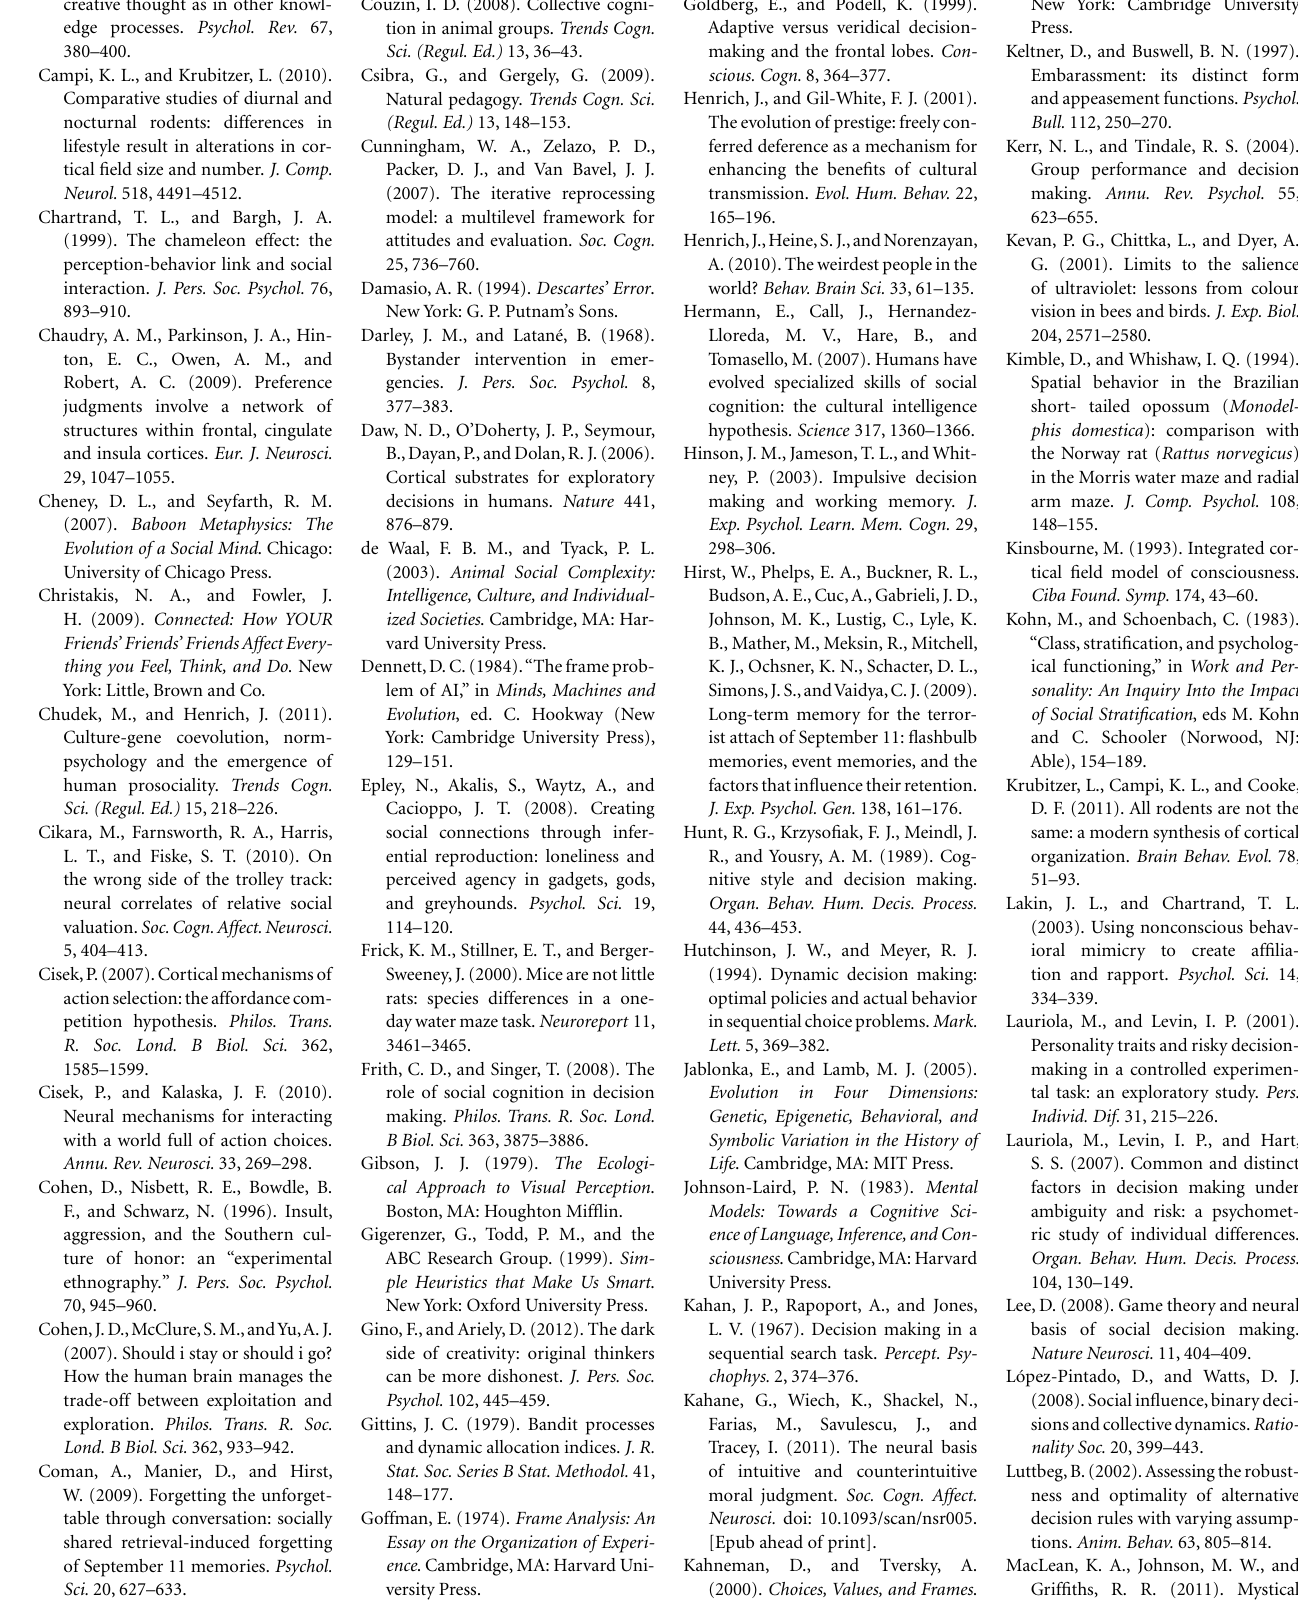
table through conversation: socially shared retrieval-induced